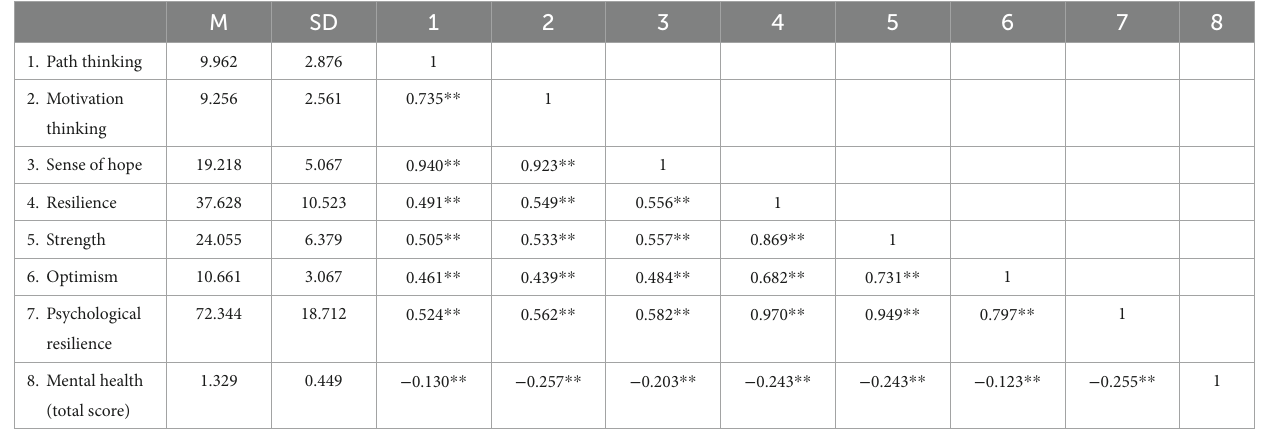
TABLE 1 Descriptive analysis and correlation coefficients of the study